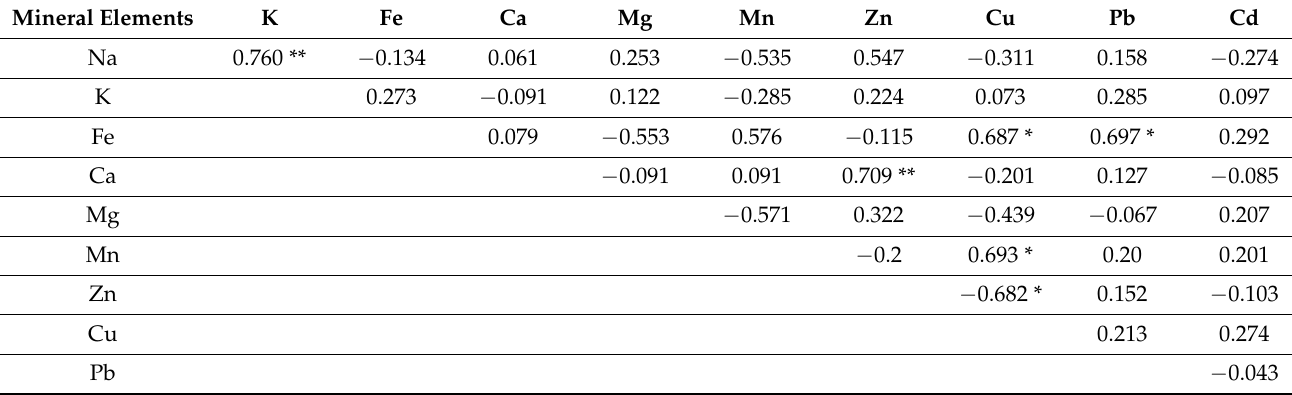
Table 5. Correlation coefficients (r xy ) for the levels of selected mineral elements and toxic metals in the hair of red deer. Mineral Elements